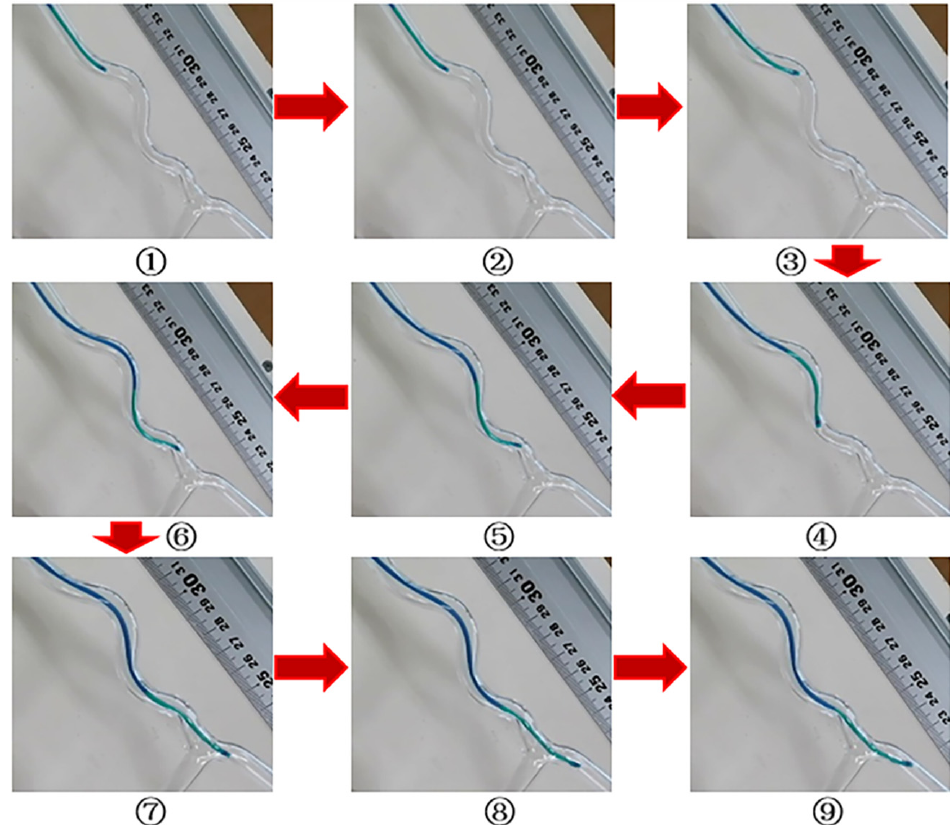
Figure 18. The corresponding position of the catheter in the glass tube as shown in Figure 17.